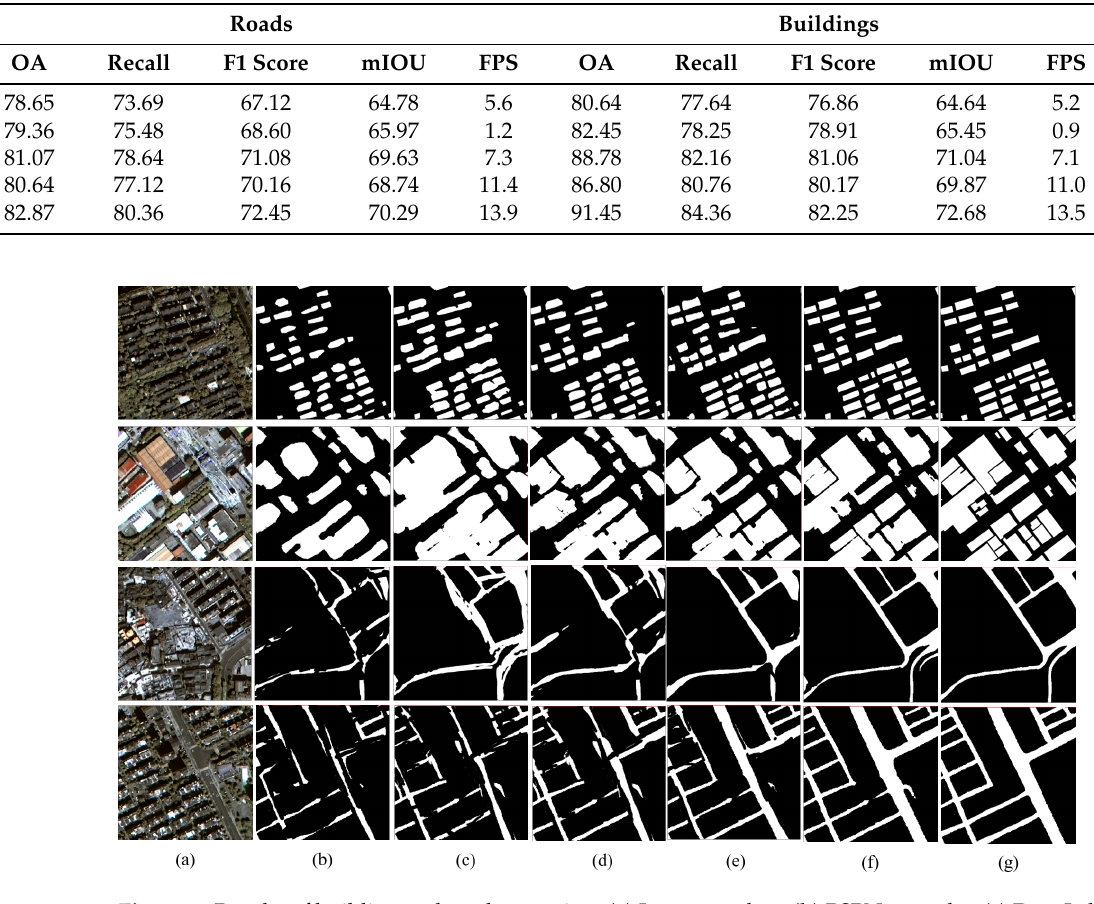
Figure 7. Results of building and road extraction. ( a ) Image patches. ( b ) PSPNet results. ( c ) DeepLab v3+ results. ( d ) DANet results. ( e ) Joint-Net results. ( f ) Our method results. ( g )